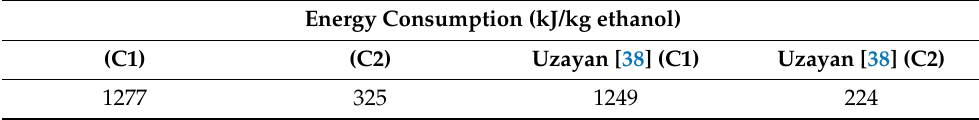
Table 1. Energy consumption of the extractive distillation process.